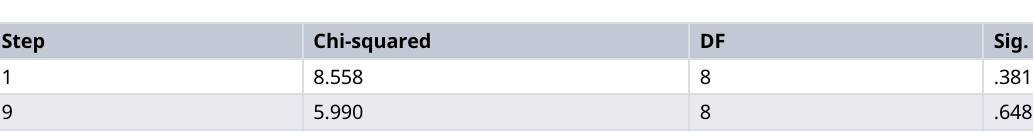
pervious malaria treatment ( p =0.15), population density ( p =0.05), and age group ( p =0.00) were significant predictors Table 2. Hosmer – Lemeshow test.